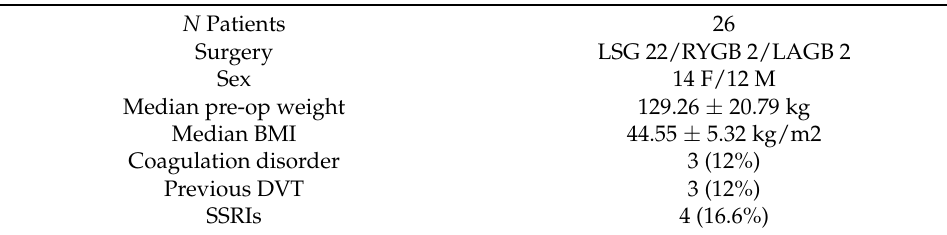
Table 1. Survey patient characteristics.